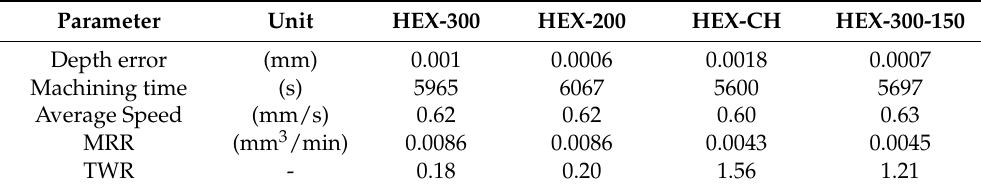
Table 4. Micro-EDM performance.